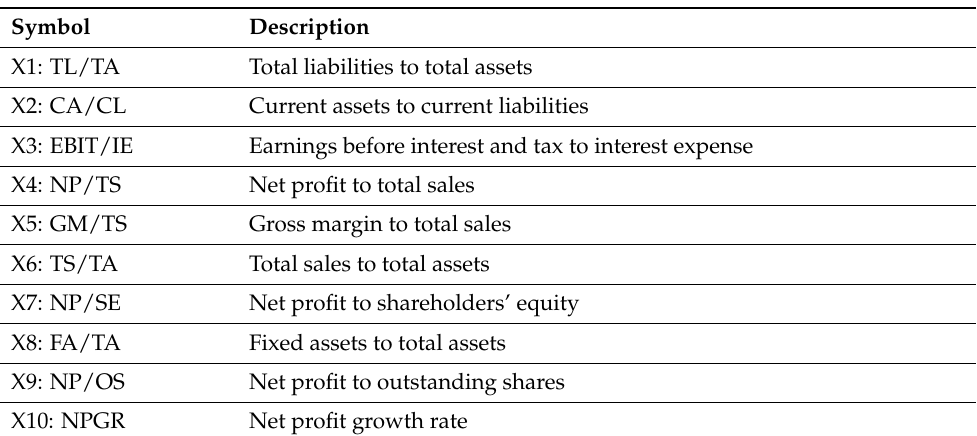
Table 5. The predictors.